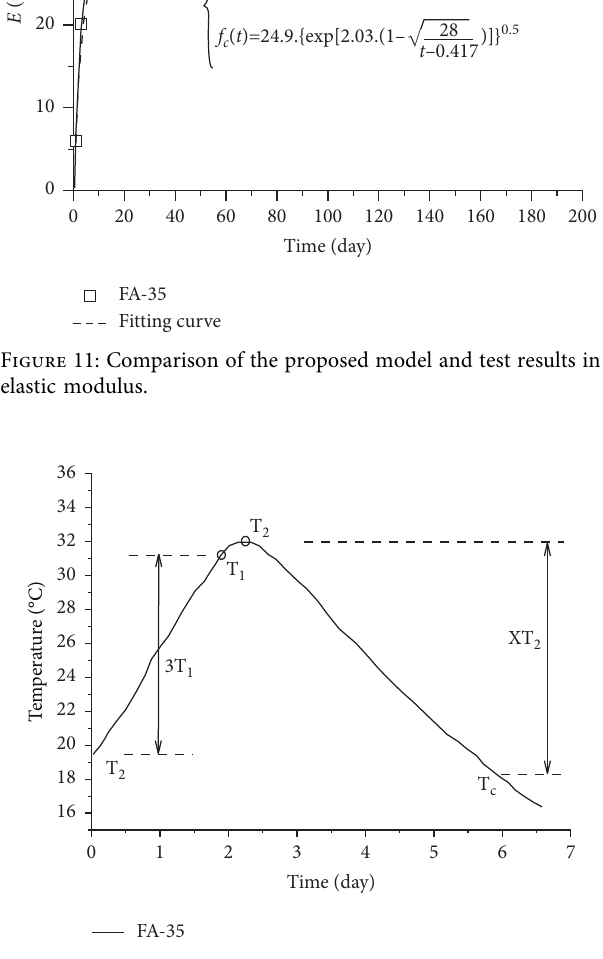
Figure 12: Temperature history under semiadiabatic conditions.